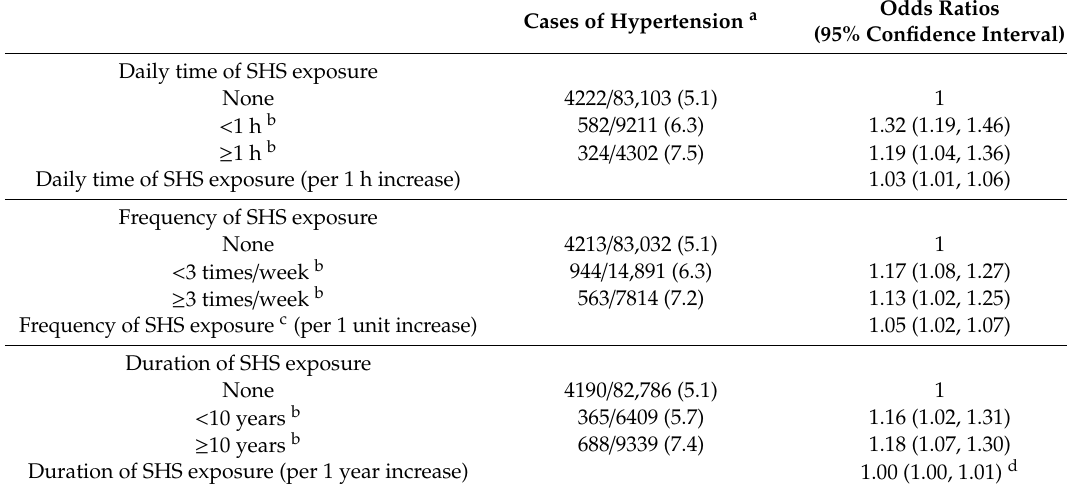
Table 4. Multivariate logistic regression analyses for the association of hypertension with frequency and duration of secondhand smoke exposure in never-smokers.